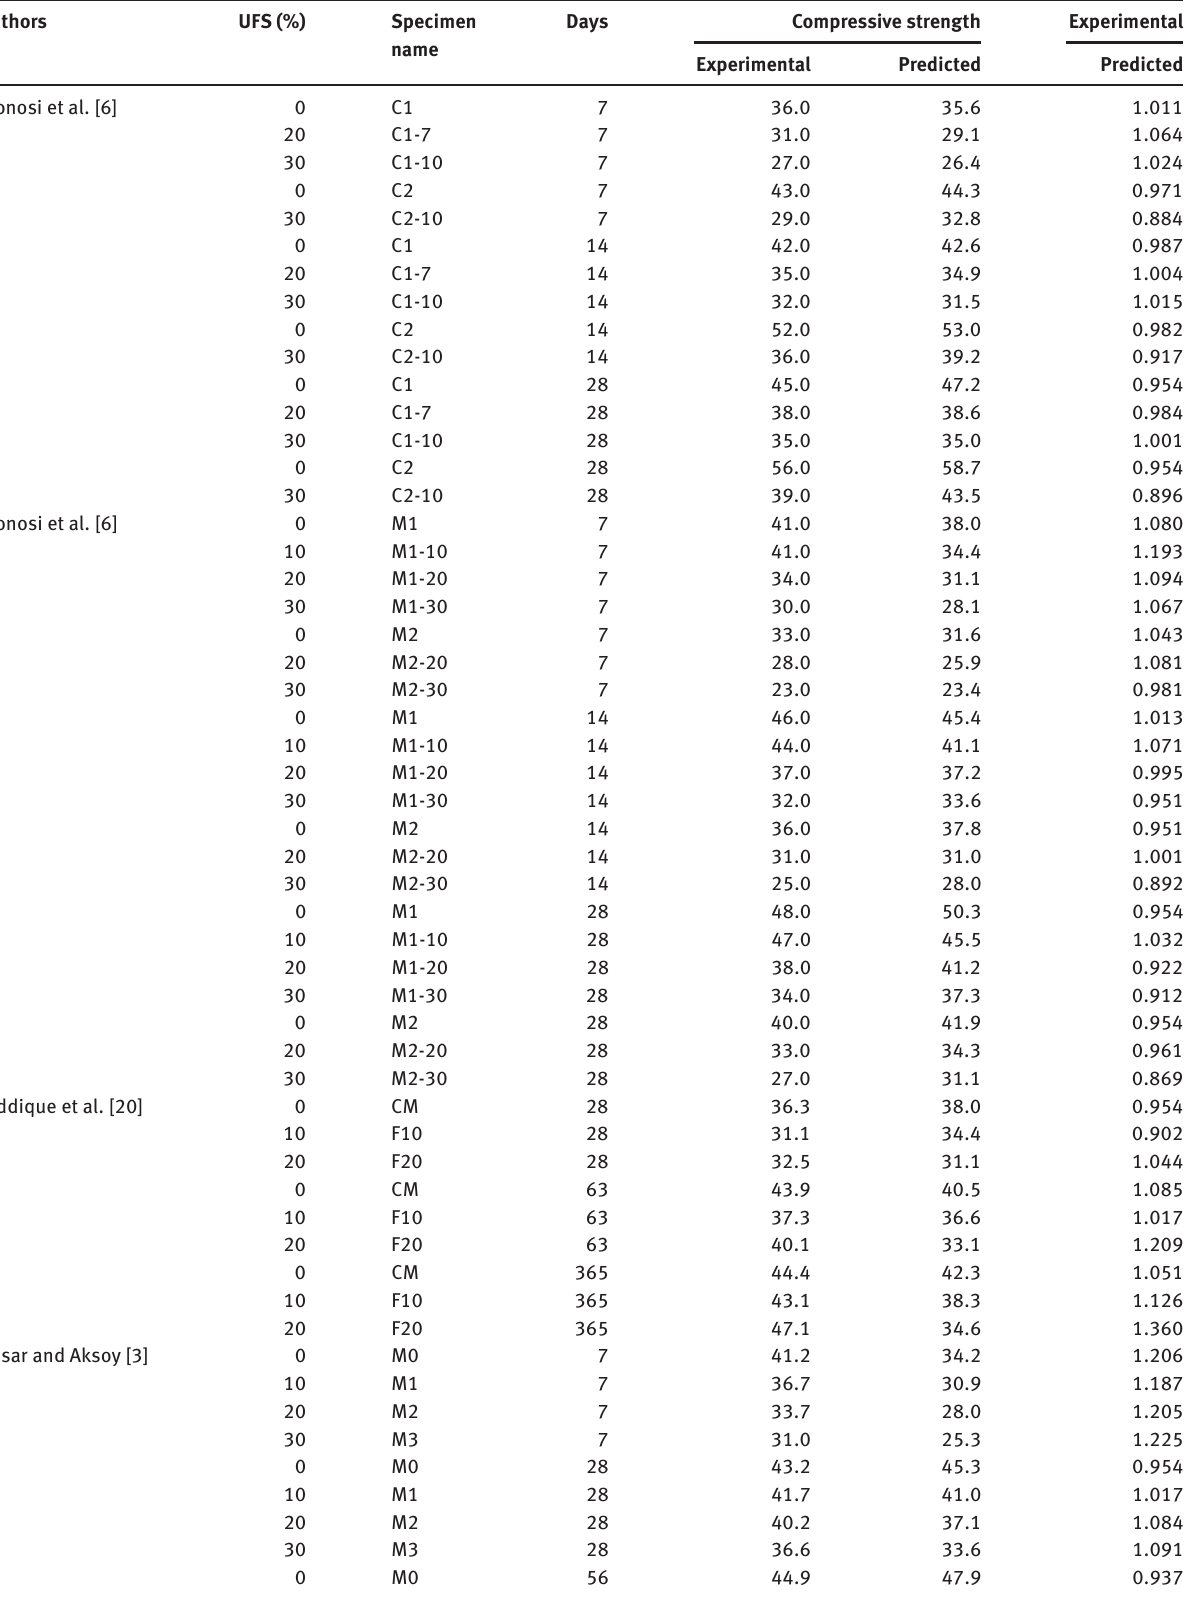
Experimental Predicted Predicted